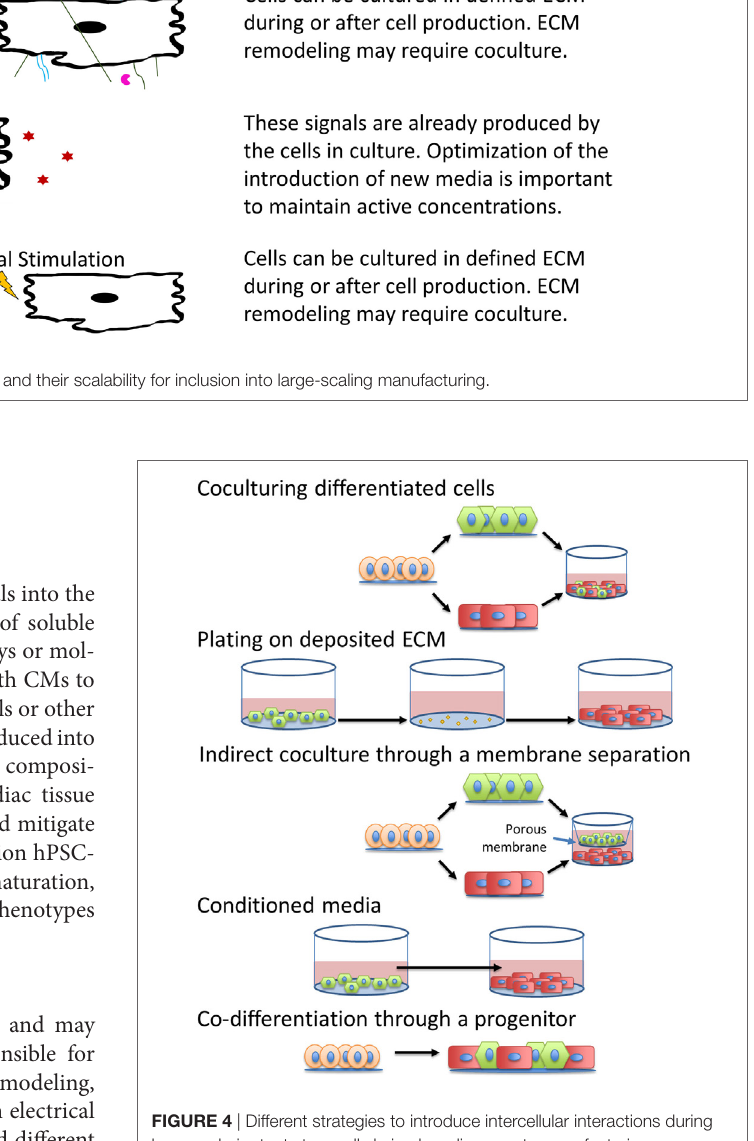
FiGURe 4 | Different strategies to introduce intercellular interactions during human pluripotent stem cell-derived cardiomyocyte manufacturing.